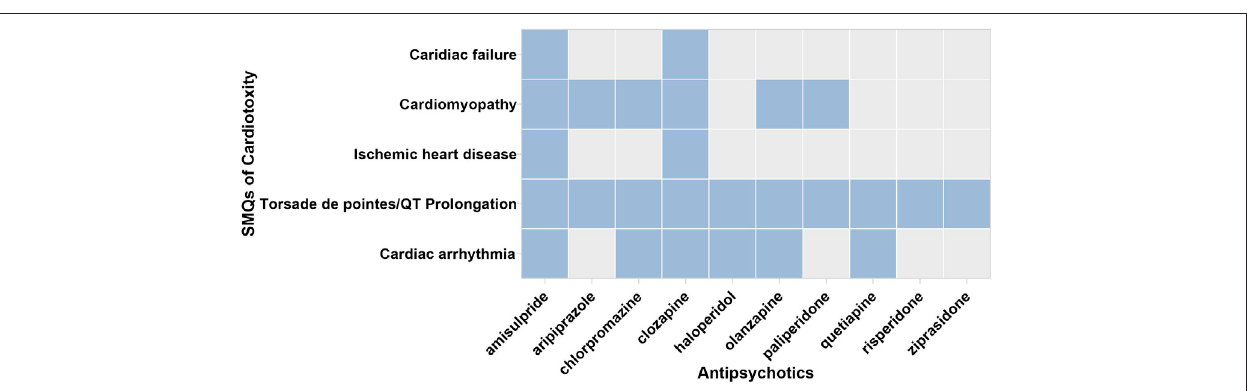
FIGURE 2 | The associations between APs and respective SMQs. SMQ: the blue blocks represent the signi fi cant associations between APs and SMQs; the gray blocks represent the nonsigni fi cant association between APs and SMQs.